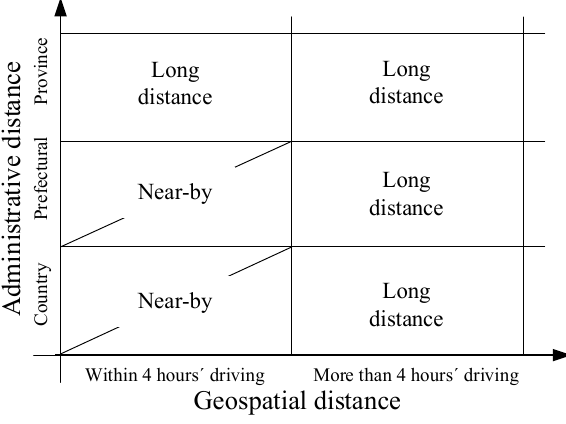
Figure 3. Migration distance.